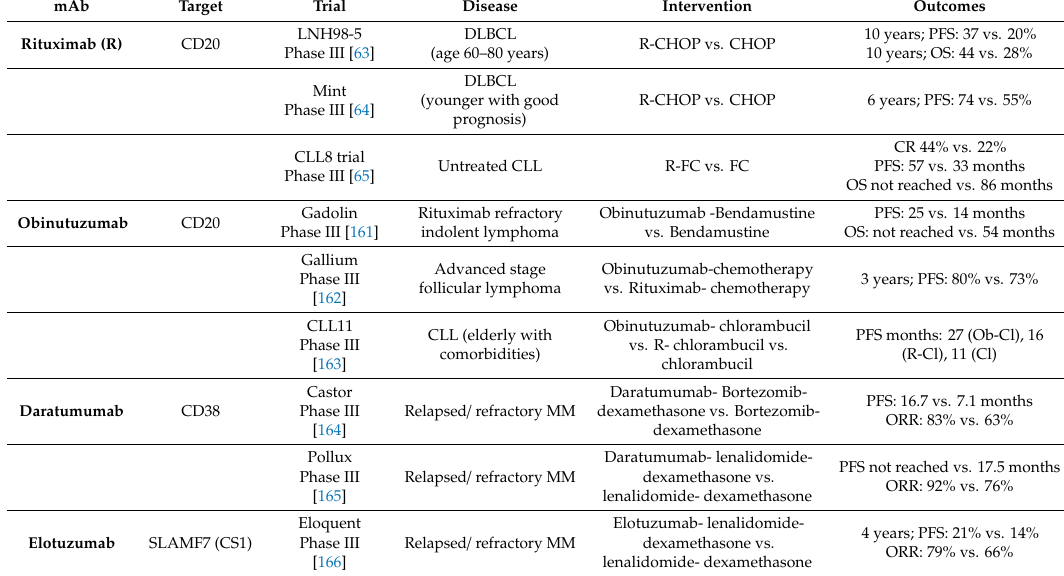
Table 3. Monoclonal antibodies, which are currently approved for hematological malignancies, that promote NK cells cell-mediated ADCC. These mAbs have a direct antineoplastic e ff ect and additional mechanisms of action including ADCC. The ADCC activity of these antibodies may vary among diseases and its relative contribution of these drugs to the e ffi cacy remains to be fully established. ADCC, antibody-dependent cell-mediated cytotoxicity; R, rituximab; DLBCL, di ff use large-B-cell lymphoma; CLL, chronic lymphocytic leukemia; MM, multiple myeloma; CHOP, cyclophosphamide, doxorubicin, vincristine, prednisone; FC, fludarabine-cyclophosphamide; PFS, progression free survival; OS, overall survival, CR, complete remission; ORR, overall response